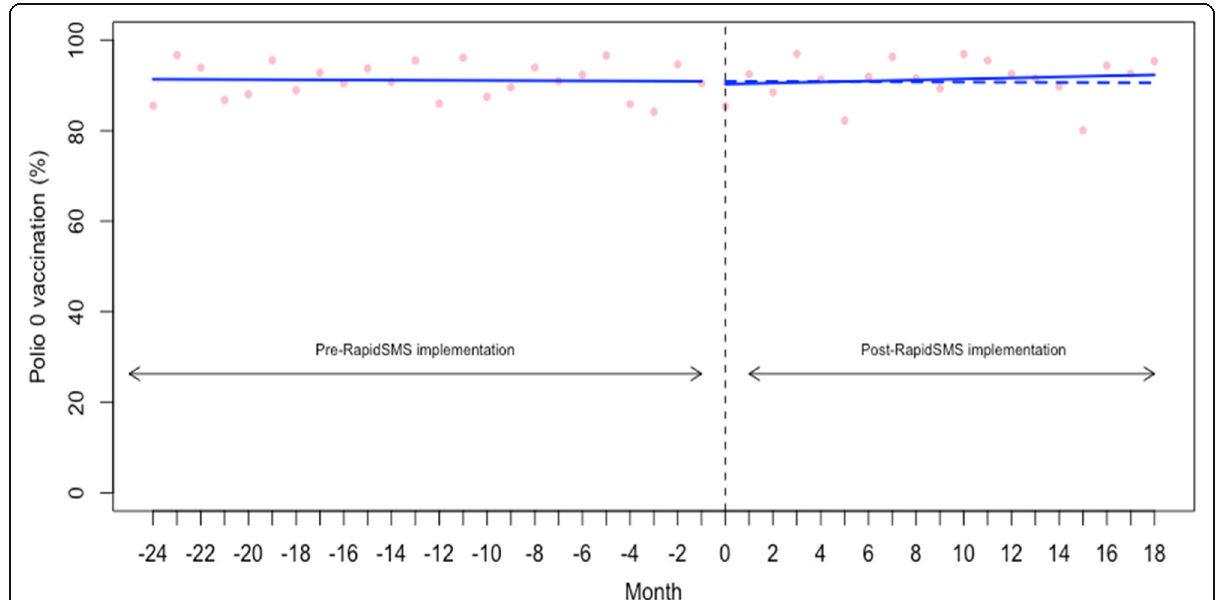
Fig. 6 Interrupted time series analysis of polio 0